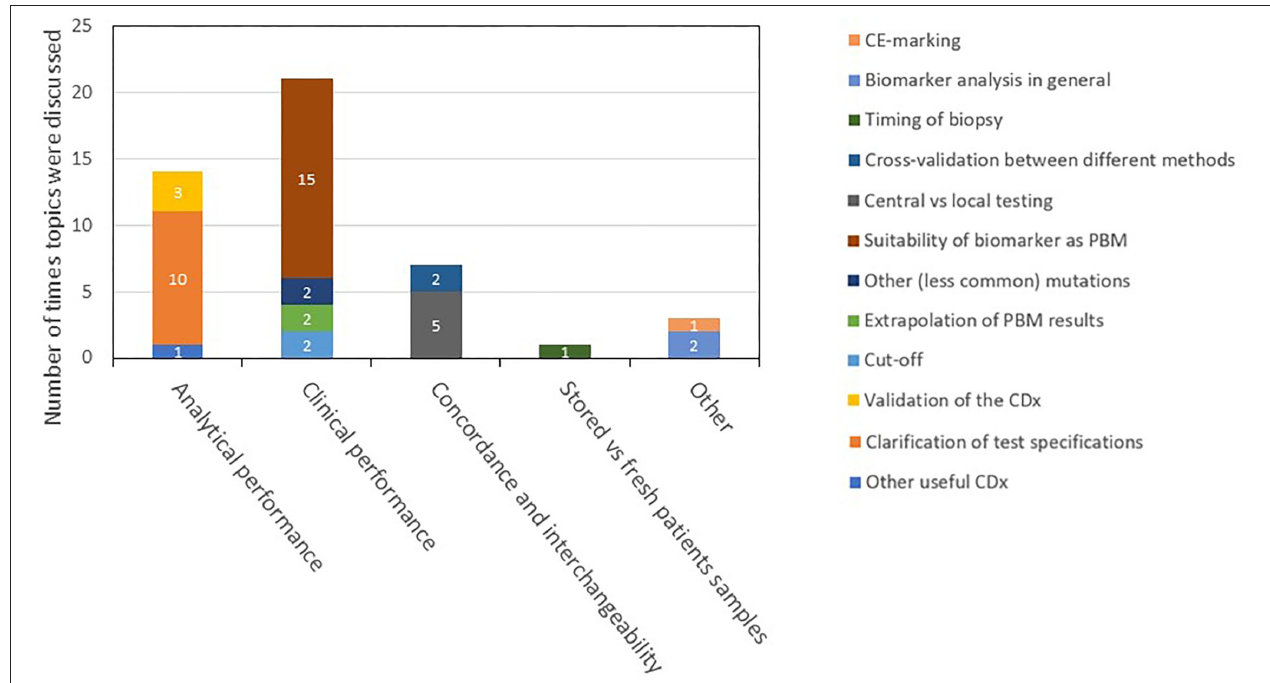
FIGURE 5 | Description and categorization of CDx found in the day 120 ARs . The four topics of CDx analytical performance, clinical performance, concordance and interchangeability, and testing of stored vs. fresh patient samples were further divided into subtopics. Remarks that did not fit to any of the four topics were categorized as “other.” AR, assessment report; CDx, companion diagnostic; EPAR, European public assessment report; PBM, predictive